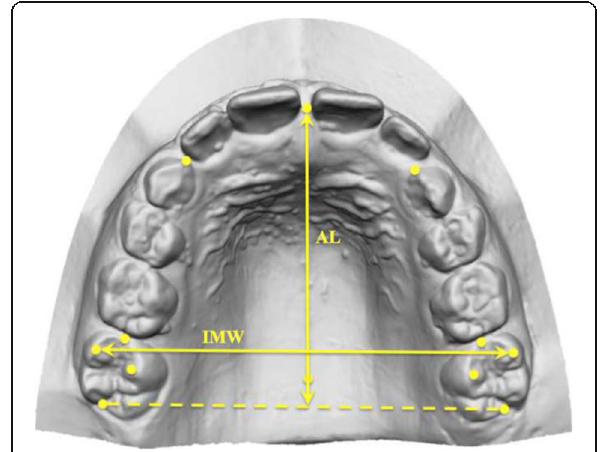
Fig. 6 Representation of the space measurements. Sum of the anterior segments (SAS) = b + c; available arch space (AAS) = a + b + c + d; right/affected (R-Af) available space = a + b; left/unaffected (L-Un) available space = c +